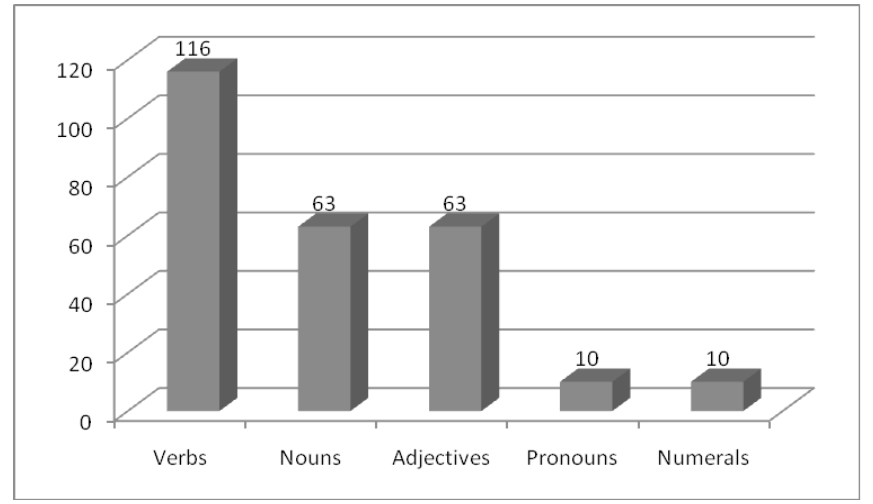
Figure 1. Number of Structural Models for Different Parts of